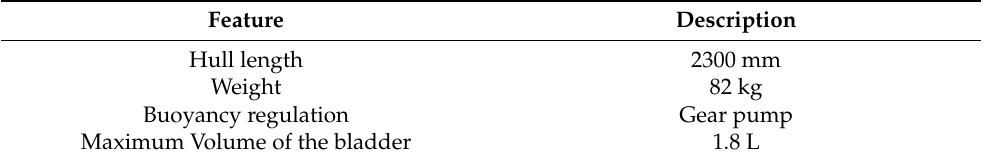
Table 1. Main specifications of Zhejiang University hybrid underwater profiler (ZJU–HUP).